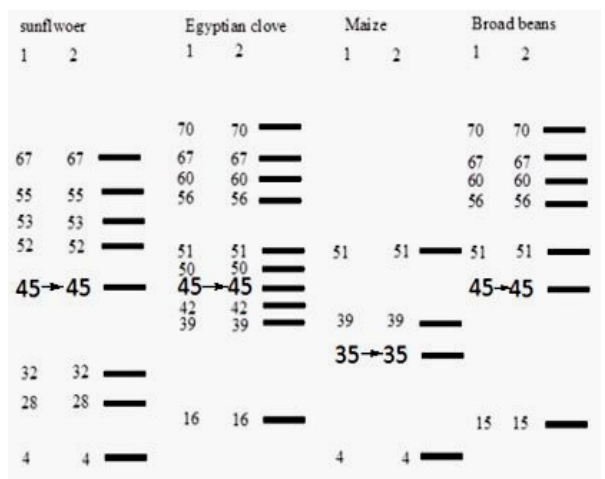
Fig. 2. Electrophoretic separation of albumin and globulin fractions of four pollen pellets: 1 - albumin; 2 -